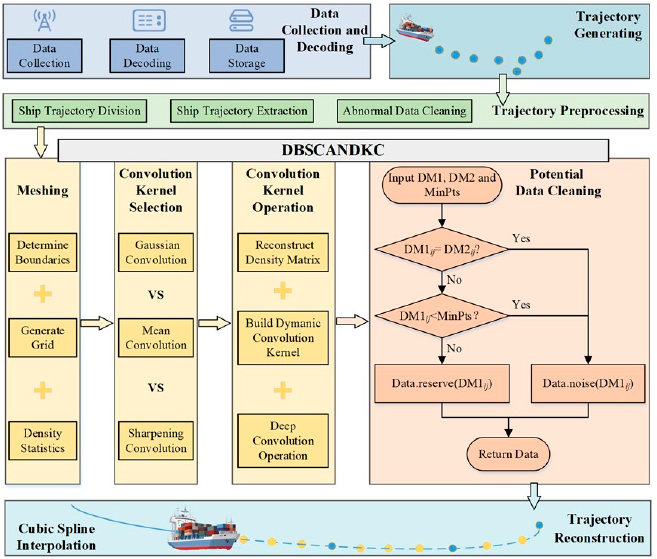
Figure 1. The flowchart of the proposed methodology.